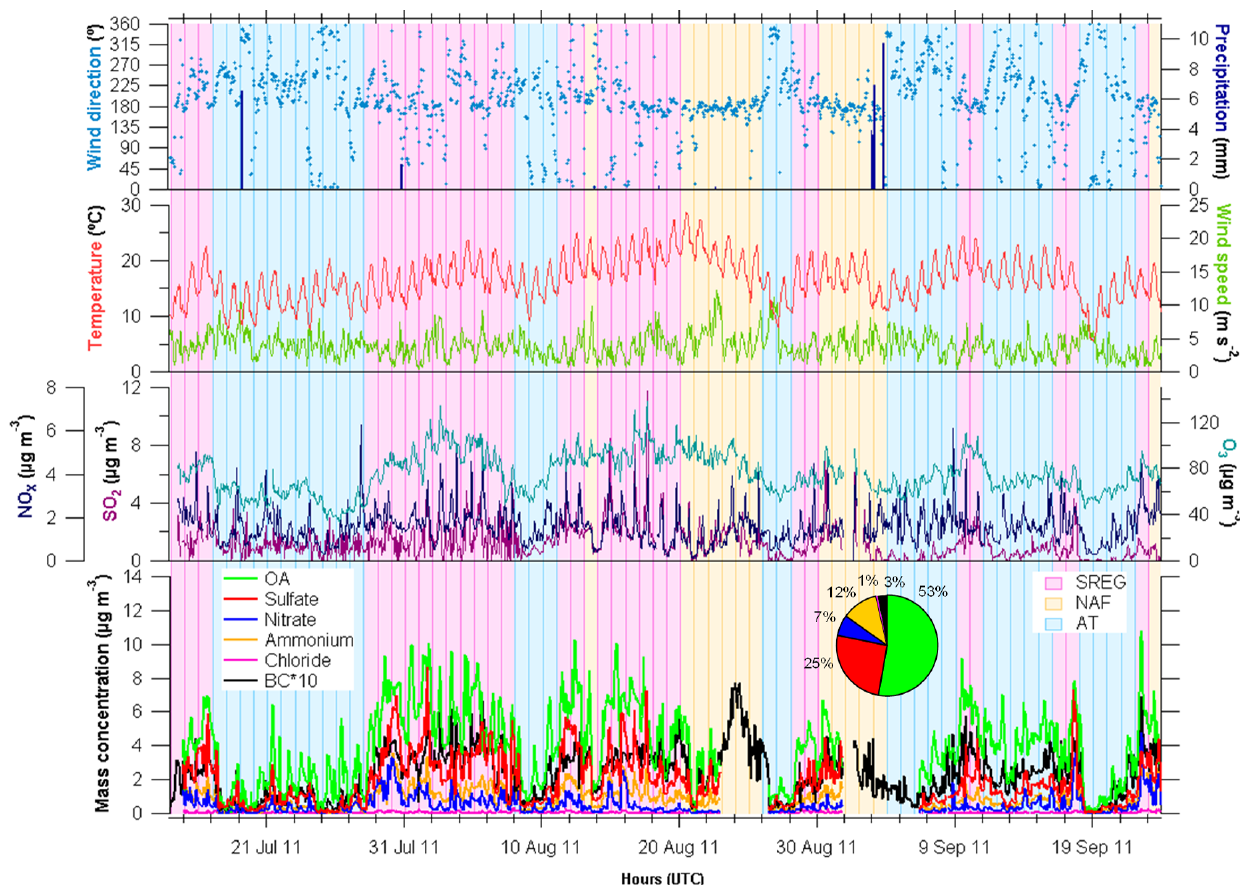
Figure 5. Time series of wind direction, precipitation, temperature, wind speed, concentrations of nitrogen oxides (NO x ), sulfur dioxide (SO 2 ), ozone (O 3 ), and PM 1 chemical species (OA, sulfate, nitrate, ammonium, chloride and black carbon (BC)) in summer (14 July 2011– 24 September 2011). Background colors correspond to daily classification of atmospheric episodes (summer regional (SREG), North African (NAF), and Atlantic (AT)) and the pie chart corresponds to the average chemical composition for the summer